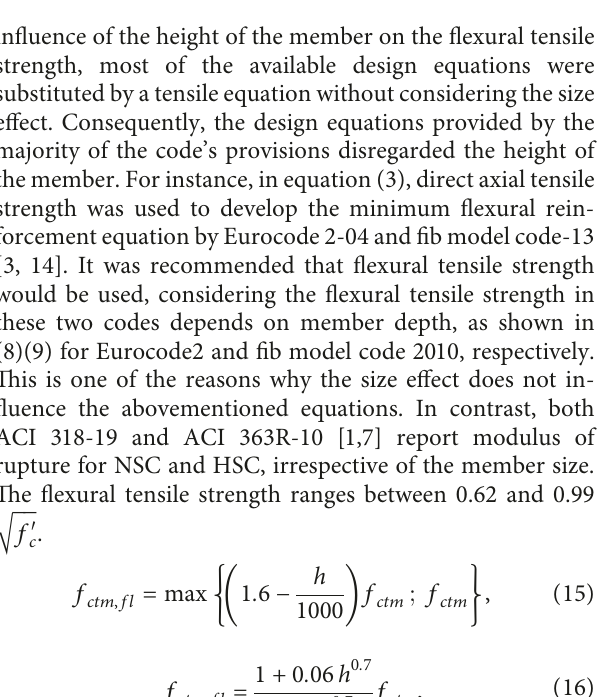
Figure 4: Effect of member depth on the flexural tensile strength of concrete for concrete f ck (cid:31)